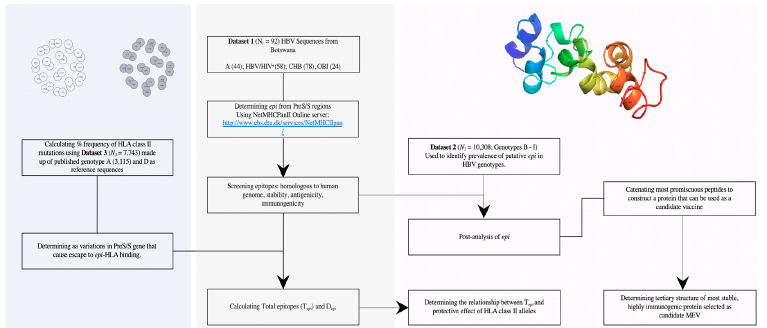
Figure 1. Schema illustrating the flow of data analysis used in this study. N = sample size; SB = strong binding peptides; WB = weak biding peptides; T epi = total predicted epitopes; PreS / S = HBV surface gene; D epi = epitope densities. Sequences were derived from patients with di ff erent clinical outcomes: − (HBV / HIV; CHB; OBI)—HIV = human immunodeficiency virus; OBI = occult hepatitis B infection, CHB = chronic hepatitis B infection, HBV / HIV = coinfection. The blue colored segment shows the pipeline used to evaluate the diversity of epi . The grey segment is the pipeline used to determine epi and measure of promiscuity and conservativeness. The pink segment is the pipeline used to determine the best candidate